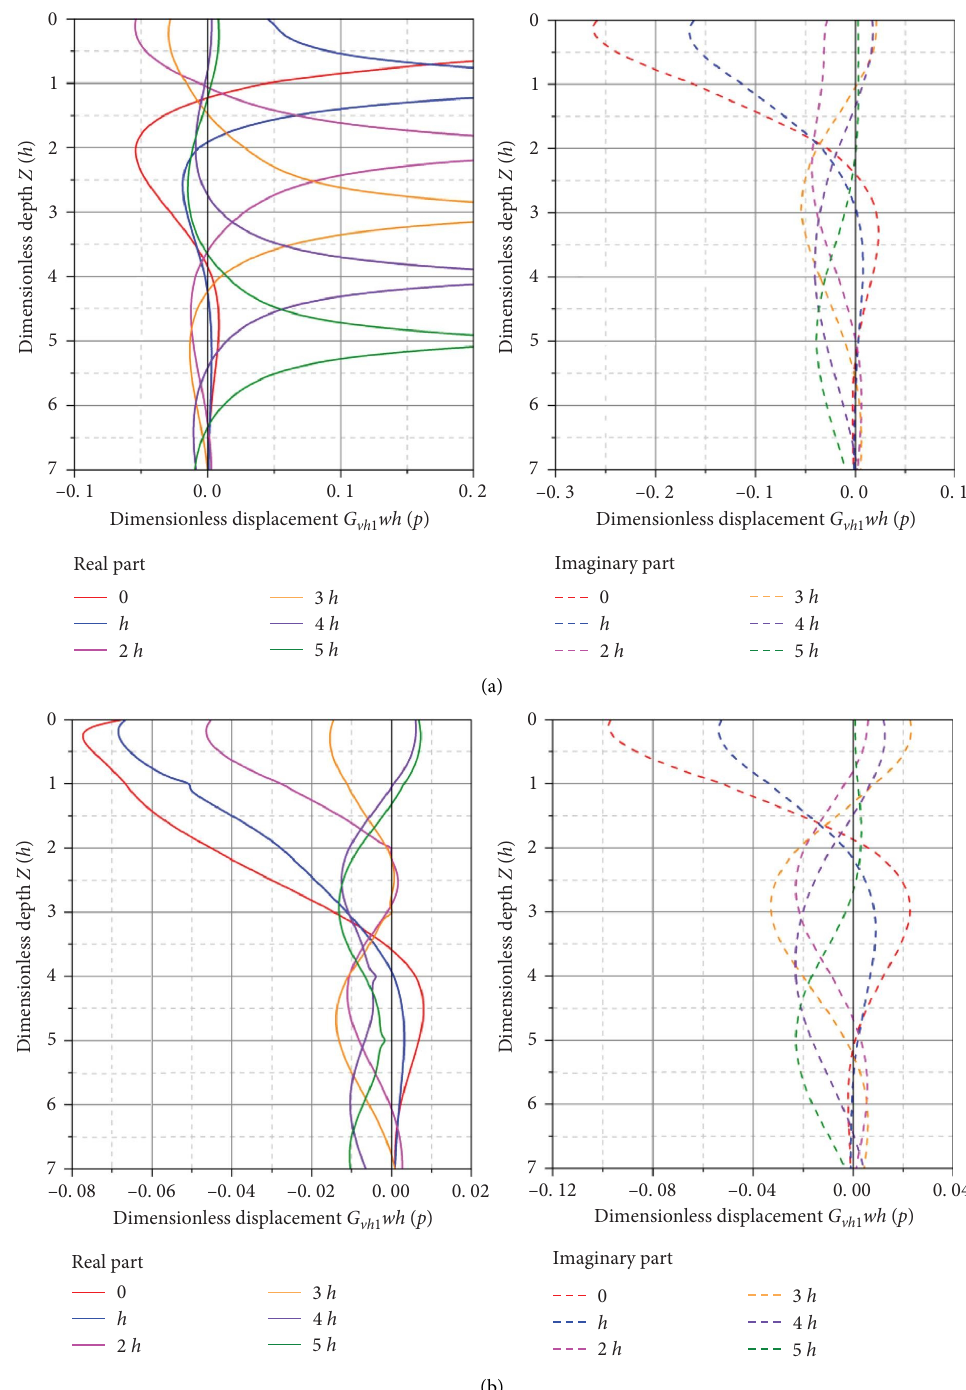
Figure 11: Te real and imaginary parts of the vertical displacement at (a) r � 0 and (b) r � h versus the dimensionless depth at a fxed dimensionless frequency of two ( ω 0 �